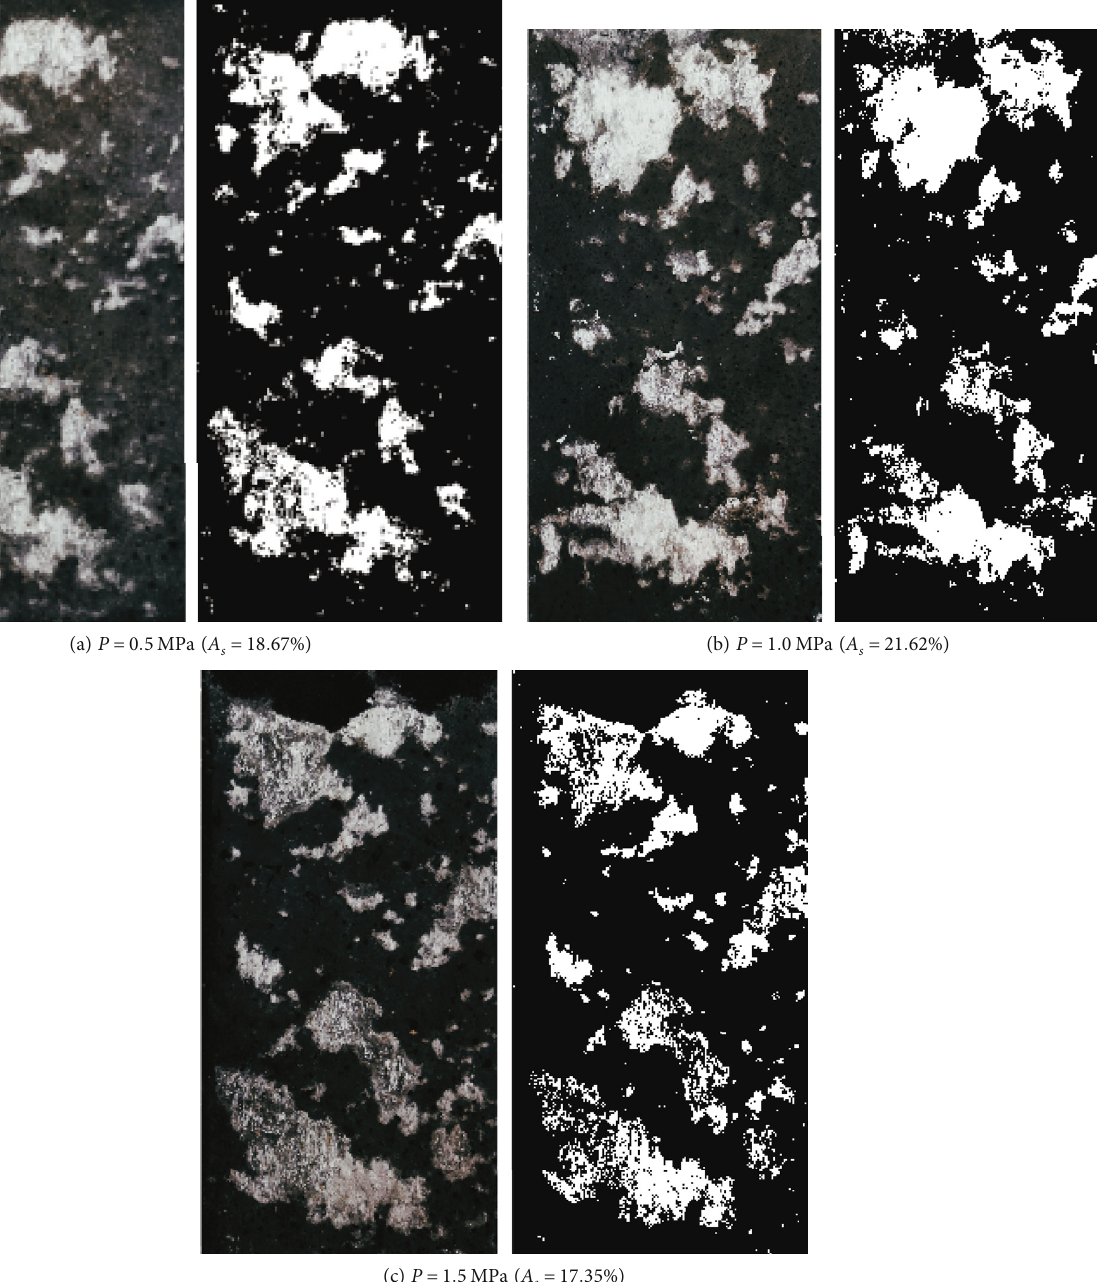
Figure 17: Failure condition of the joint when the initial normal stress is 8